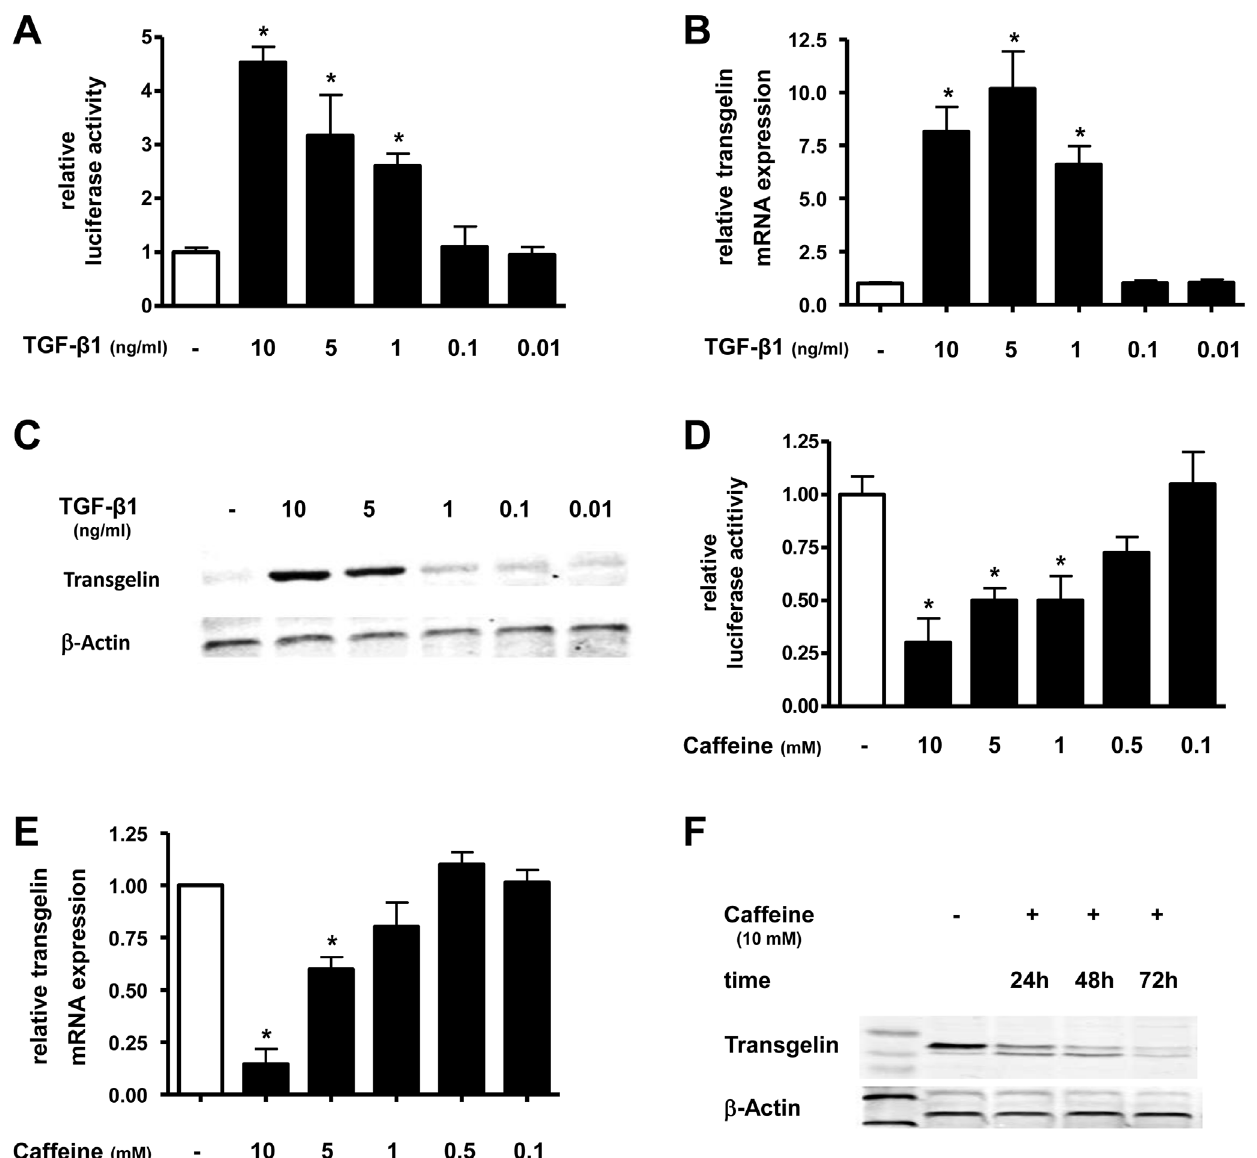
Figure 3. TGF- b 1 increases and caffeine decreases transgelin expression in lung epithelial cells. A549 cells were incubated with TGF- b 1 (A–C) or caffeine (D–F) in indicated concentrations and for various timepoints. Transgelin promoter (A + C), real-time PCR (B + E) and Western blot (C + F) analysis was performed. Means 6 SD of at least n=3 independent experiments are shown. In C + F representative immunoblots of at least three independent experiments are shown. * p , 0.05 compared to control